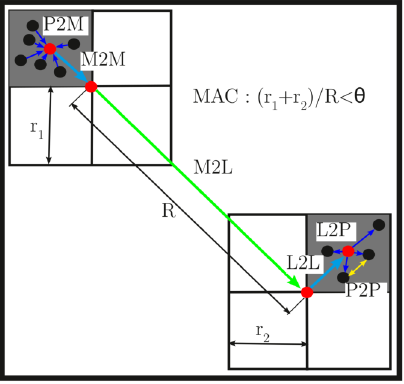
Figure 2. Flow of FMM